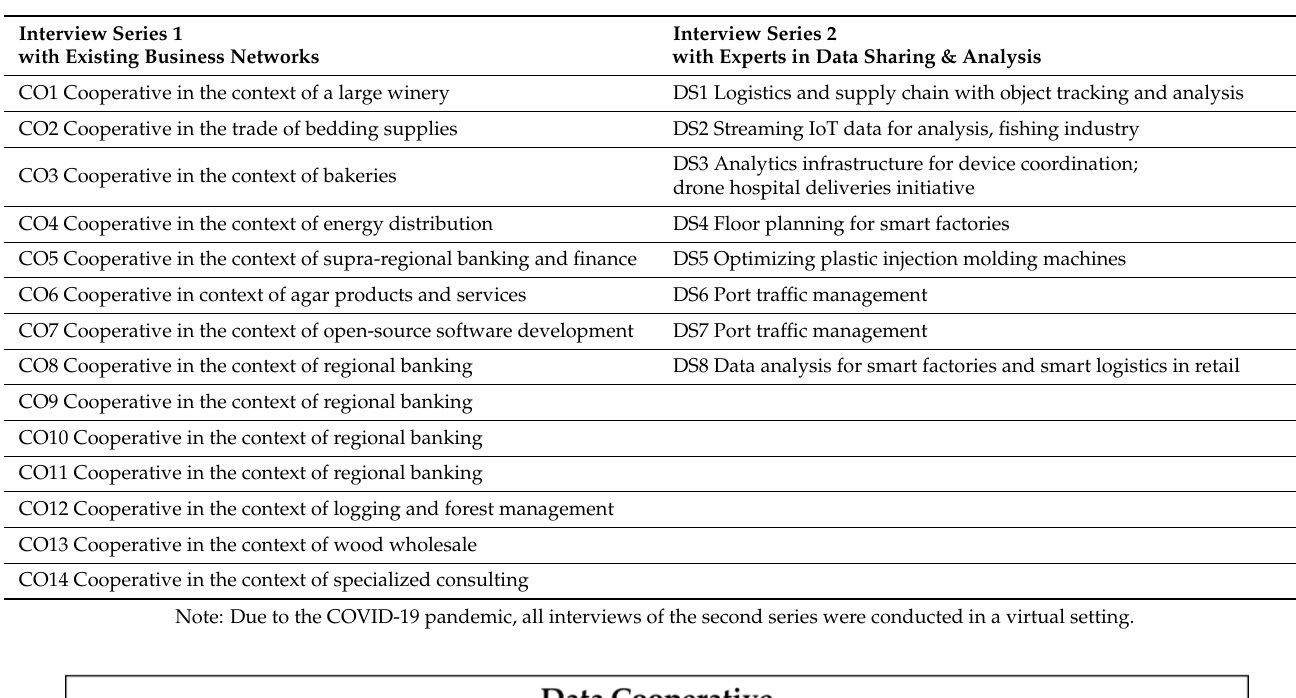
Table 1. Overview of the two interview series.